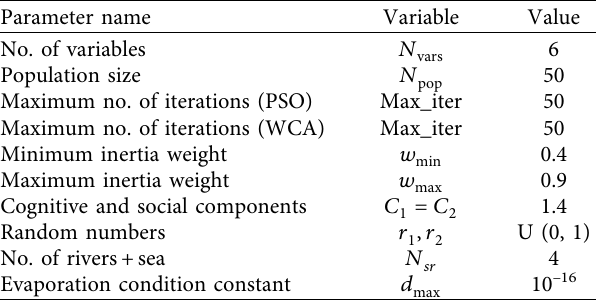
Table 5: WCA-PSO parameters [42, 45].